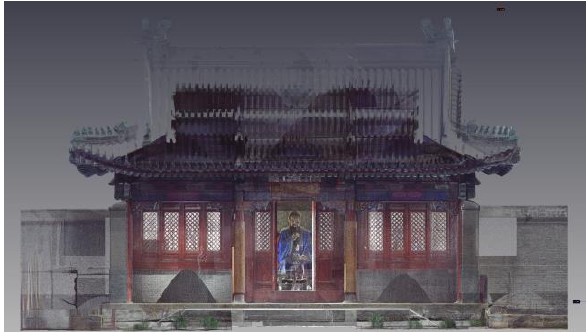
Figure 14. the Main Hall of Lu Ban Shrine, Jizhou, Tianjin, point